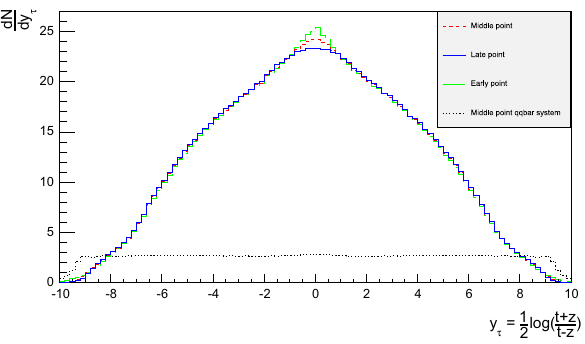
Fig. 17 Hadron number per event as a function of time for a simple q ¯ q system formed by massless quarks in the CM frame with